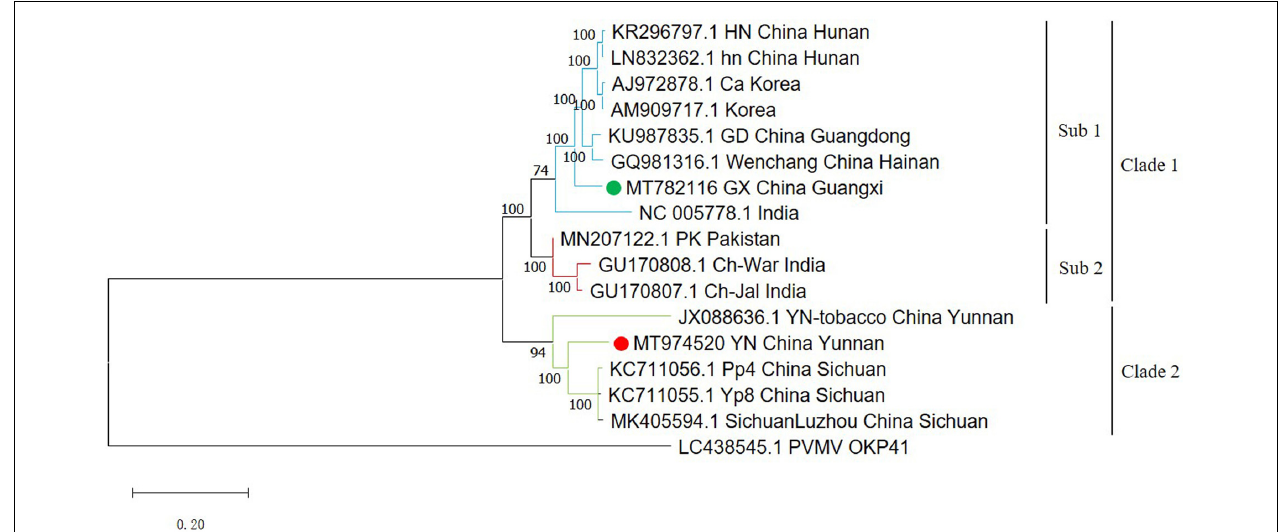
FIGURE 1 | Phylogenetic tree of 16 full-length ChiVMV isolates. The phylogenetic tree of 16 full-length ChiVMV isolates was produced using MEGA X by the maximum-likelihood (ML) method using the General Time Reversible algorithm and 1,000 bootstrap replications. The ChiVMV isolates are divided into three sub-clades which are shown in different colors. The new Guangxi and Yunnan isolates are marked by green and red circles, respectively. The number at each branch of the phylogenetic tree is the bootstrap percentage. A pepper veinal mottle virus isolate sequence (LC438545) was used as outgroup.